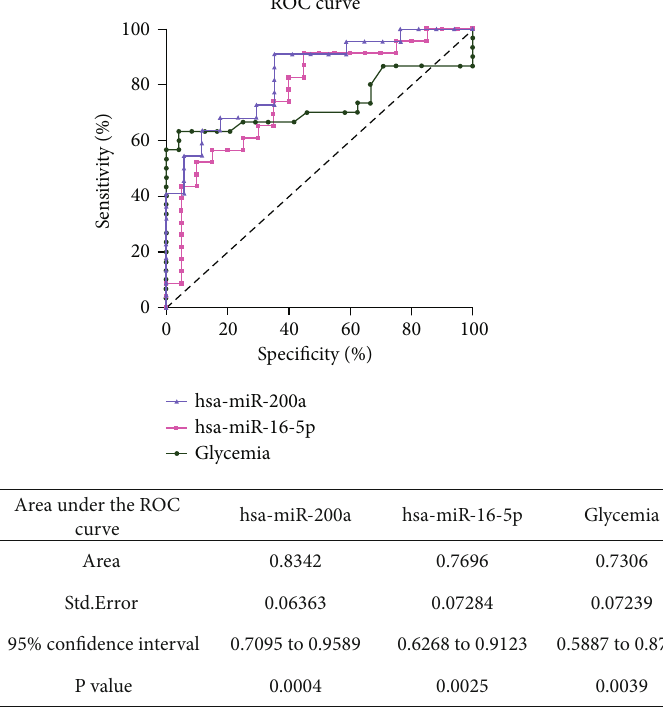
Figure 3: ROC curves of miR-200a-3p, miR-16-5p, and glucose